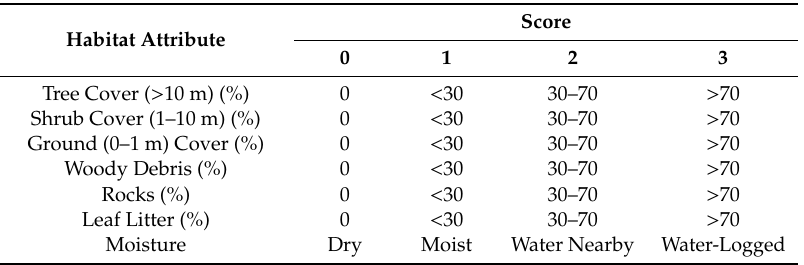
Table 1. Habitat complexity scoring system used at camera trapping sites. Adapted from Newsome and Catling